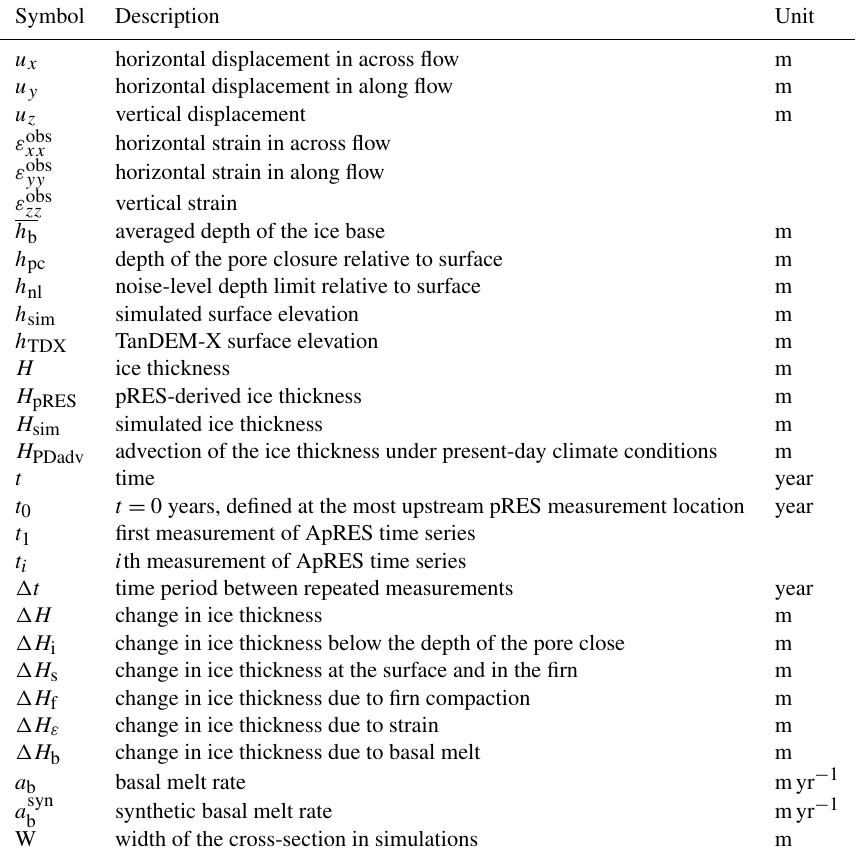
Table A2. Description of